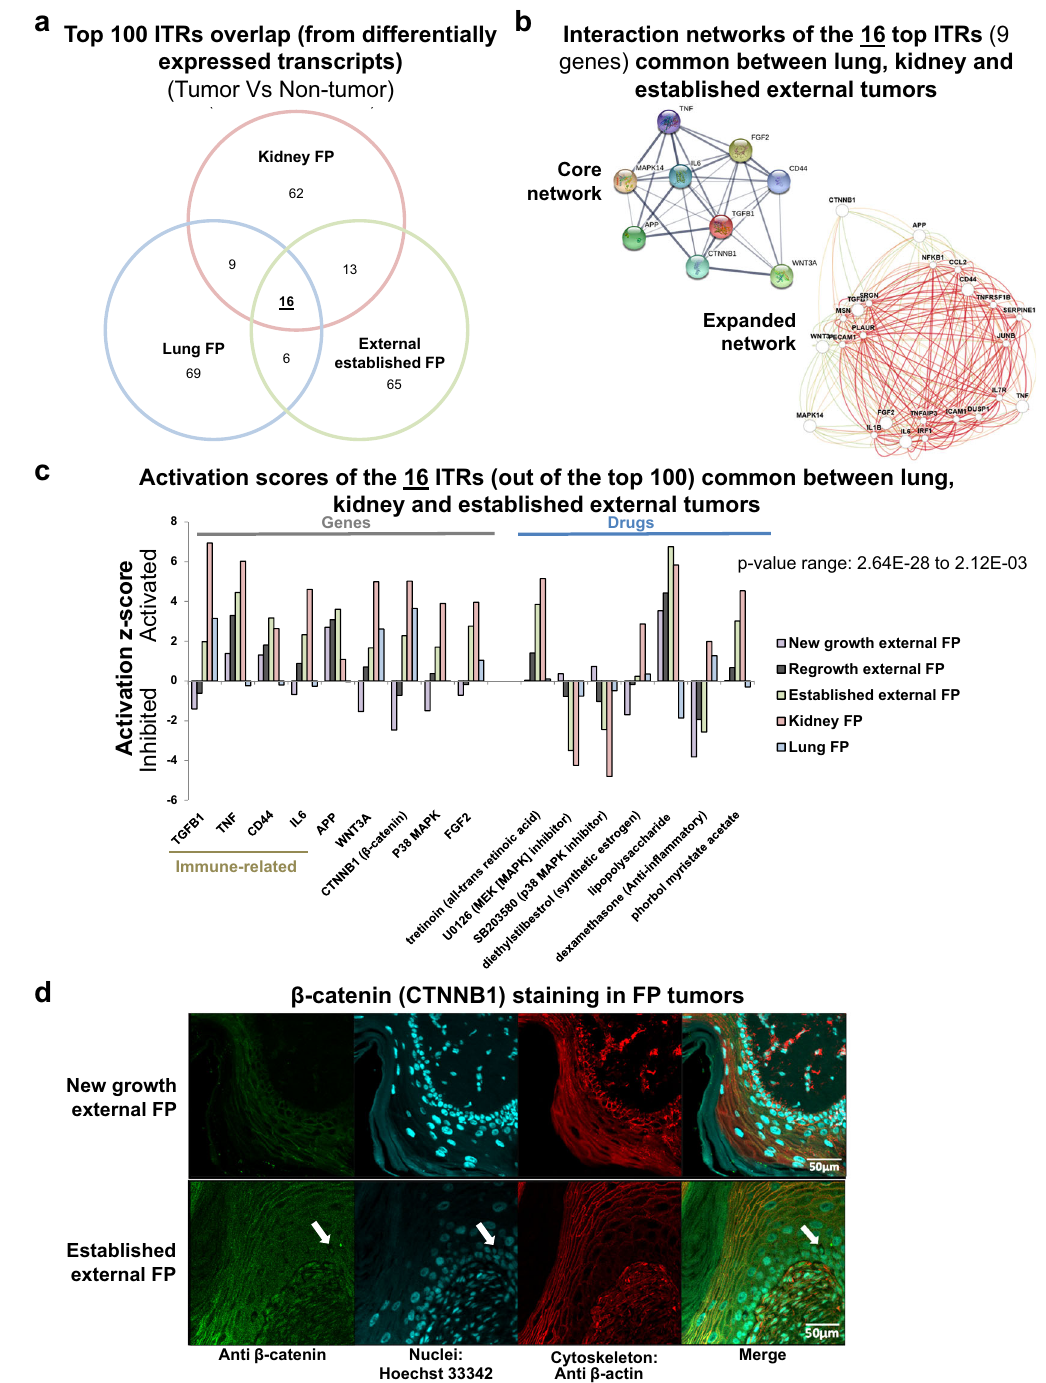
Fig. 4 Transcriptional regulator analysis revealing the cellular signaling driving fi bropapillomatosis and potential therapeutic targets. a Overlap of the top 100 inferred transcriptional regulators (ITR) of the transcripts differentially expressed in different types of FP tumors (kidney FP, lung FP, external established FP) when compared to their respective non-tumored tissue sources, as detected by IPA, ranked by P value (calculated by right-tailed Fisher ’ s exact test, with Benjamini – Hochberg correction). The 16 ITRs that were common to lung, kidney, and established external FP were selected for further analysis. b Interaction networks of the top 16 ITRs (nine genes shown, seven drugs excluded) common between lung, kidney and established external tumors. Core network generated by STRING 94 (https://string-db.org/), expanded network generated by HumanBase (https://hb. fl atironinstitute.org/). c Activation/inhibition z scores for the 16 ITRs common between lung, kidney, and established external tumors, shown for all tumor types. ITRs are segregated according to functional class, i.e., genes and drugs. d New growth and established external tumor tissue sections, stained with anti β -catenin (an ITR called as activated for three of the fi ve tumor types, see c ) and counterstained with Hoechst 33342 to visualize nuclei and Anti β -actin to visualize cellular cytoskeletons. Selected cells with nuclear (activated) β -catenin staining are indicated by white